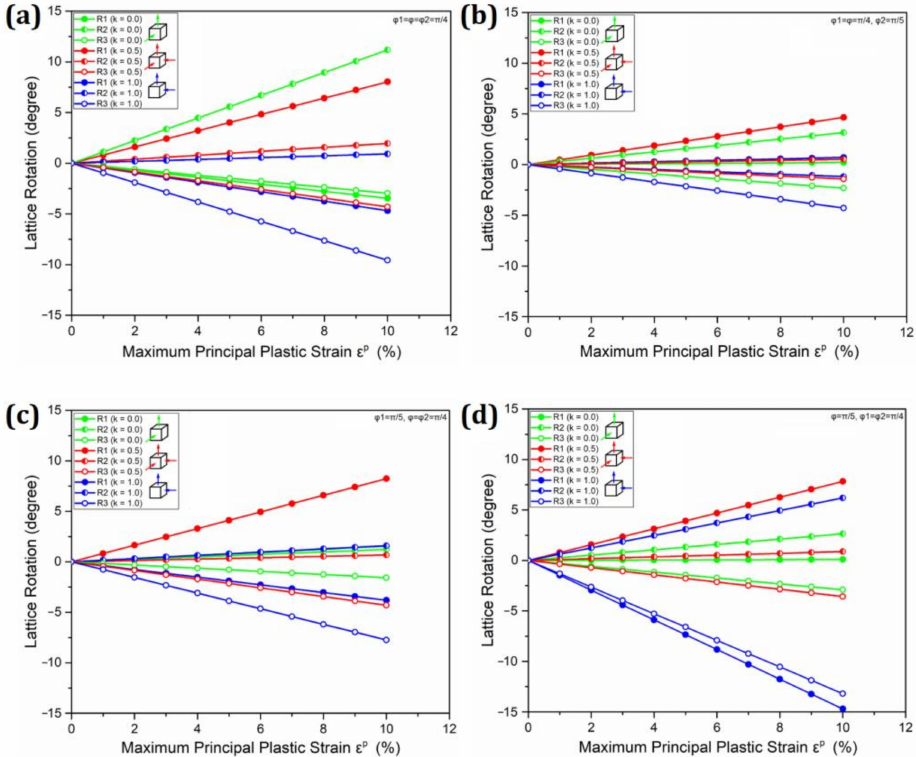
Figure 10. Linear relationship between relative lattice rotation components R 1 ( 0 ) ~ R 3 ( 0 ) and maxi- mum principal plastic strain ε p in cases of: ( a ) φ 1 = φ = φ 2 = π /4; ( b ) φ 1 = φ = π /4, φ 2 = π /5; ( c ) φ 1 = π /5, φ = φ 2 = π /4; ( d ) φ = π /5, φ 1 = φ 2 = π /4 ( k = 0.0, 0.5,